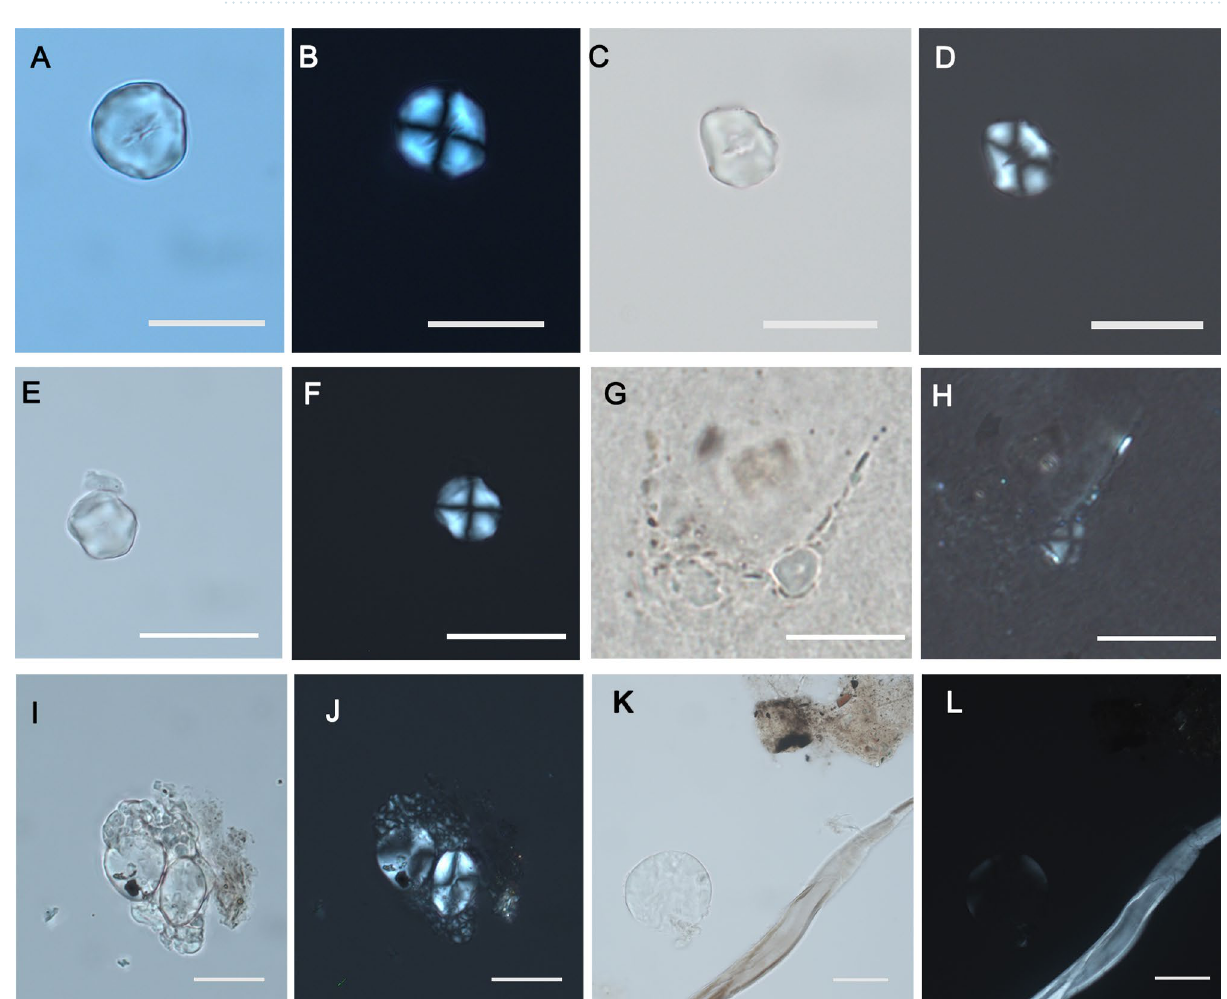
Figure 4. ( A – L ) Starch grains embedded in El Espinoso’s dental calculus in light microscope and polarised light microscope. ( A – H ) Polyhedral starch grains with central hilum and fissures associated with the Paniceae tribe; ( I – L ) Round to oval starch grains "bimodal distribution" consistent with the Triticeae tribe. (Scale bar, 20